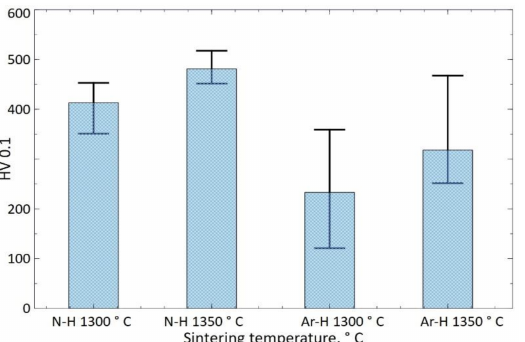
Figure 12. Hardness of samples sintered under N 2 -5%H 2 or Ar-5%H 2 at 1300 and 1350 ◦